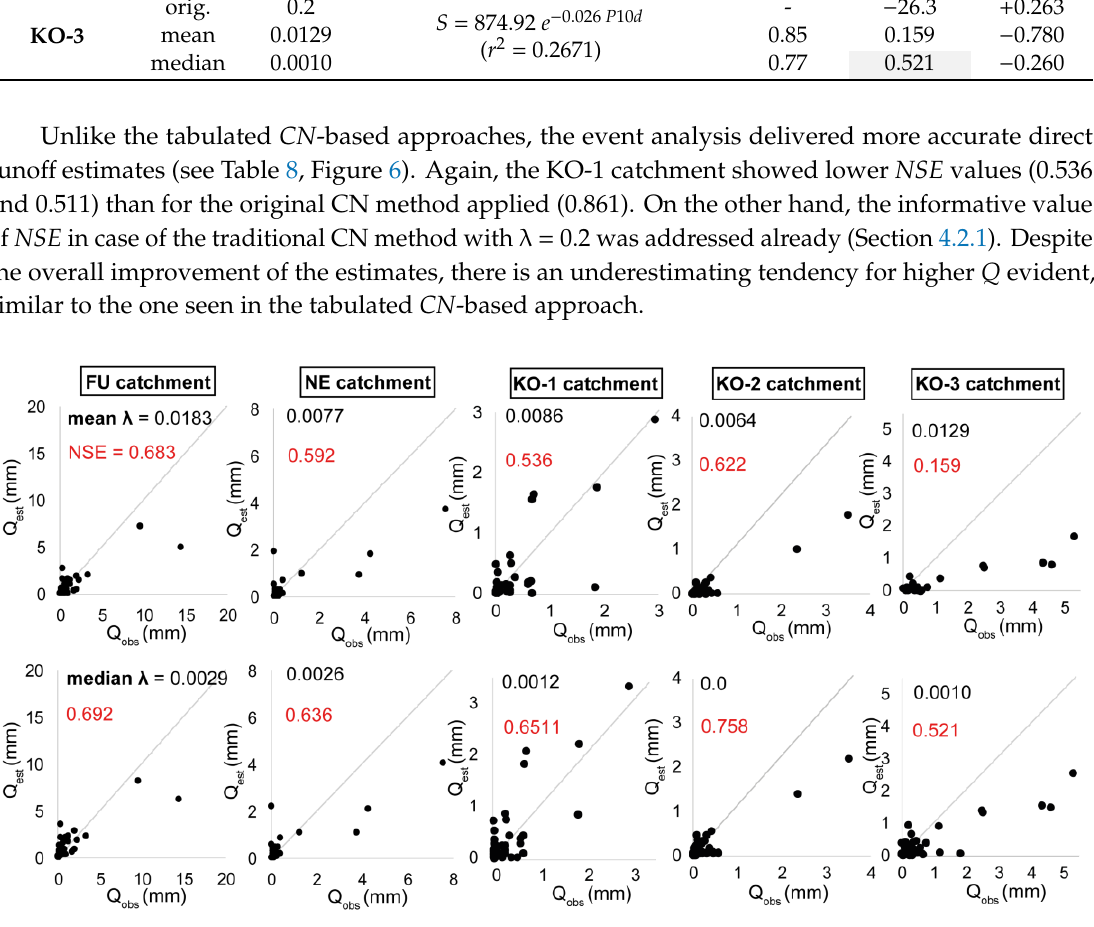
Figure 7. Comparison of observed direct runoff heights with those simulated using pairs of S and λ identified by means of model fitting procedure. The validation was carried out both with (all) and without delimitation of clusters according to P 5d (clustered P 5d ) and P 10d (clustered P 10d ).